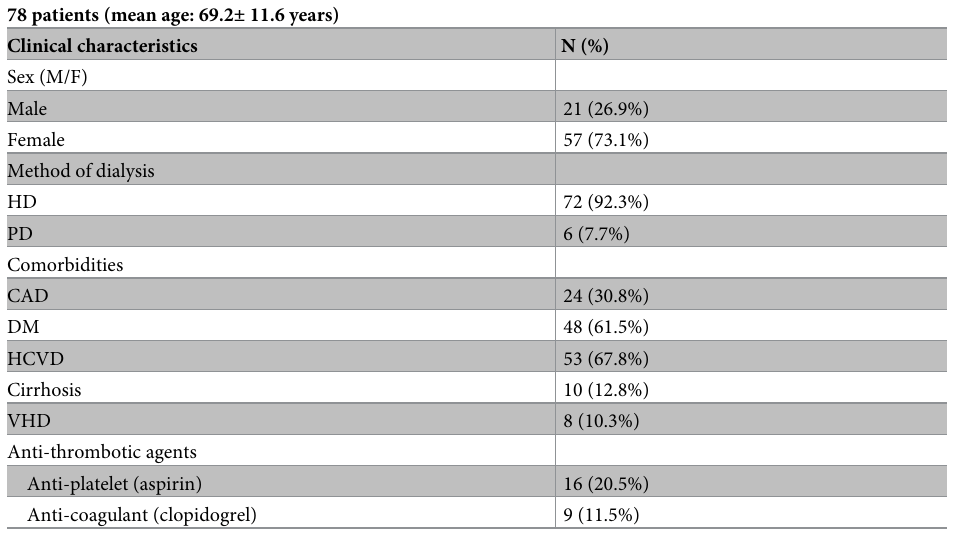
Table 1. Clinical characteristics of uremic patients with obscure gastrointestinal bleeding who underwent single- balloon enteroscopy. 78 patients (mean age: 69.2 ± 11.6